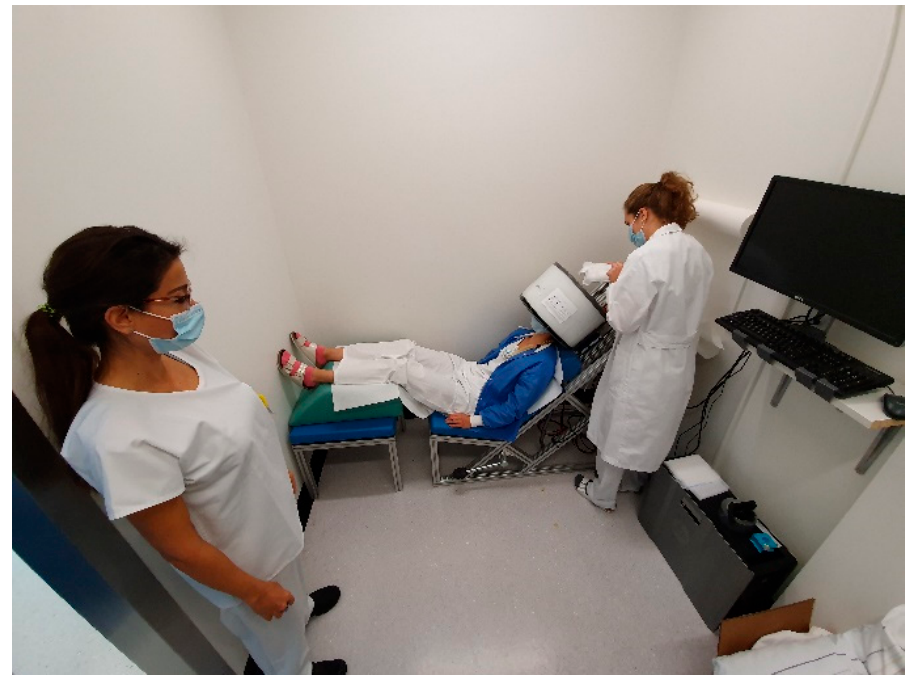
Figure 1. Picture of BPET with three medical technologists practicing its use during the site initiation visit.